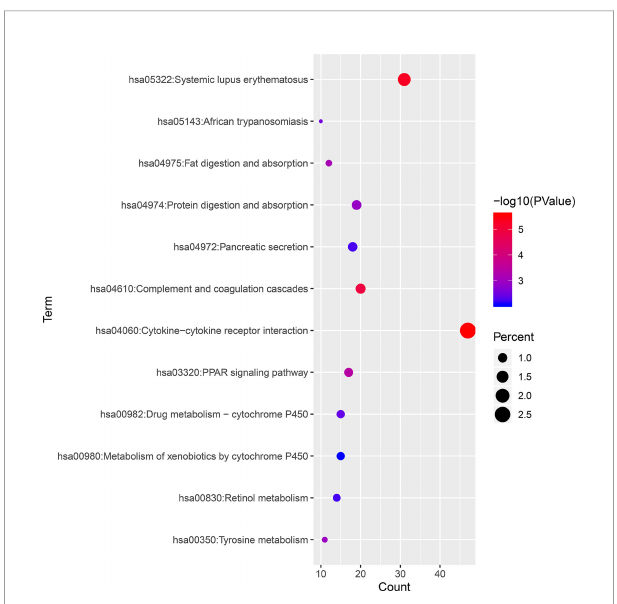
FIGURE 4 | KEGG pathway enrichment analysis of 1,855 DEGs associated with ccRCC. KEGG, Kyoto Encyclopedia of Genes and Genomes; ccRCC, clear cell renal cell carcinoma; DEGs, differentially expressed